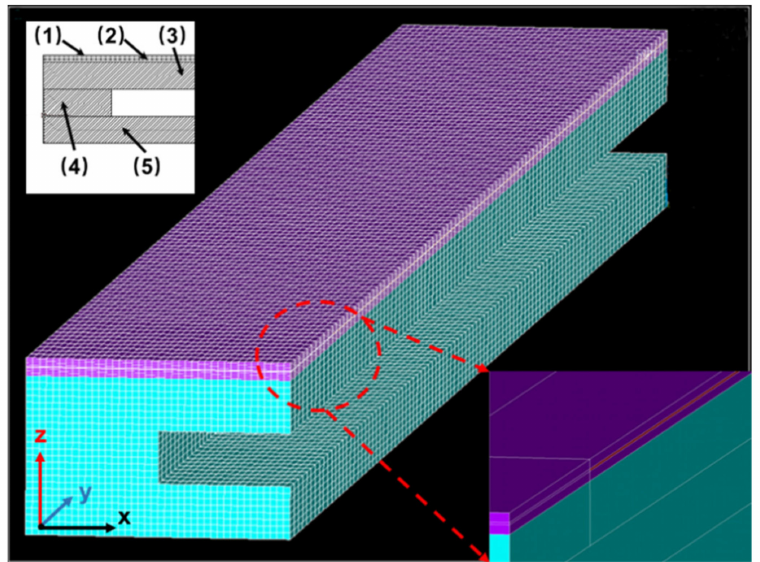
Figure 2. The quarter simplified model and related mesh generation of the nitrogen–oxygen